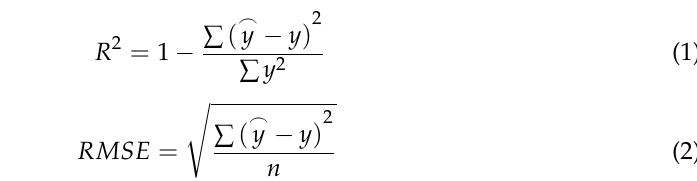
Figure 3. Seasonal trajectories of solar radiation (R g ), air temperature (T a ), vapour pressure deficit (VPD), and precipitation (P) during 2003–2010 at the QYZ flux site (evergreen needleleaf forest) for 8-day periods. For x -axis, the data refer to week of year (WOY) ranging from 1 to 46.